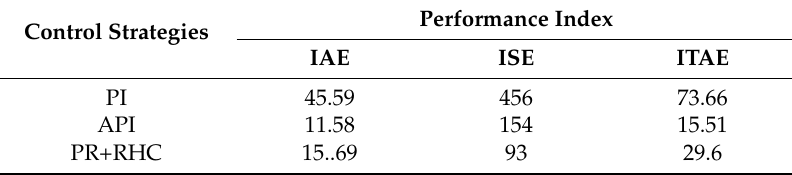
Table 13. Performance evaluation of the designed control strategies for I q .